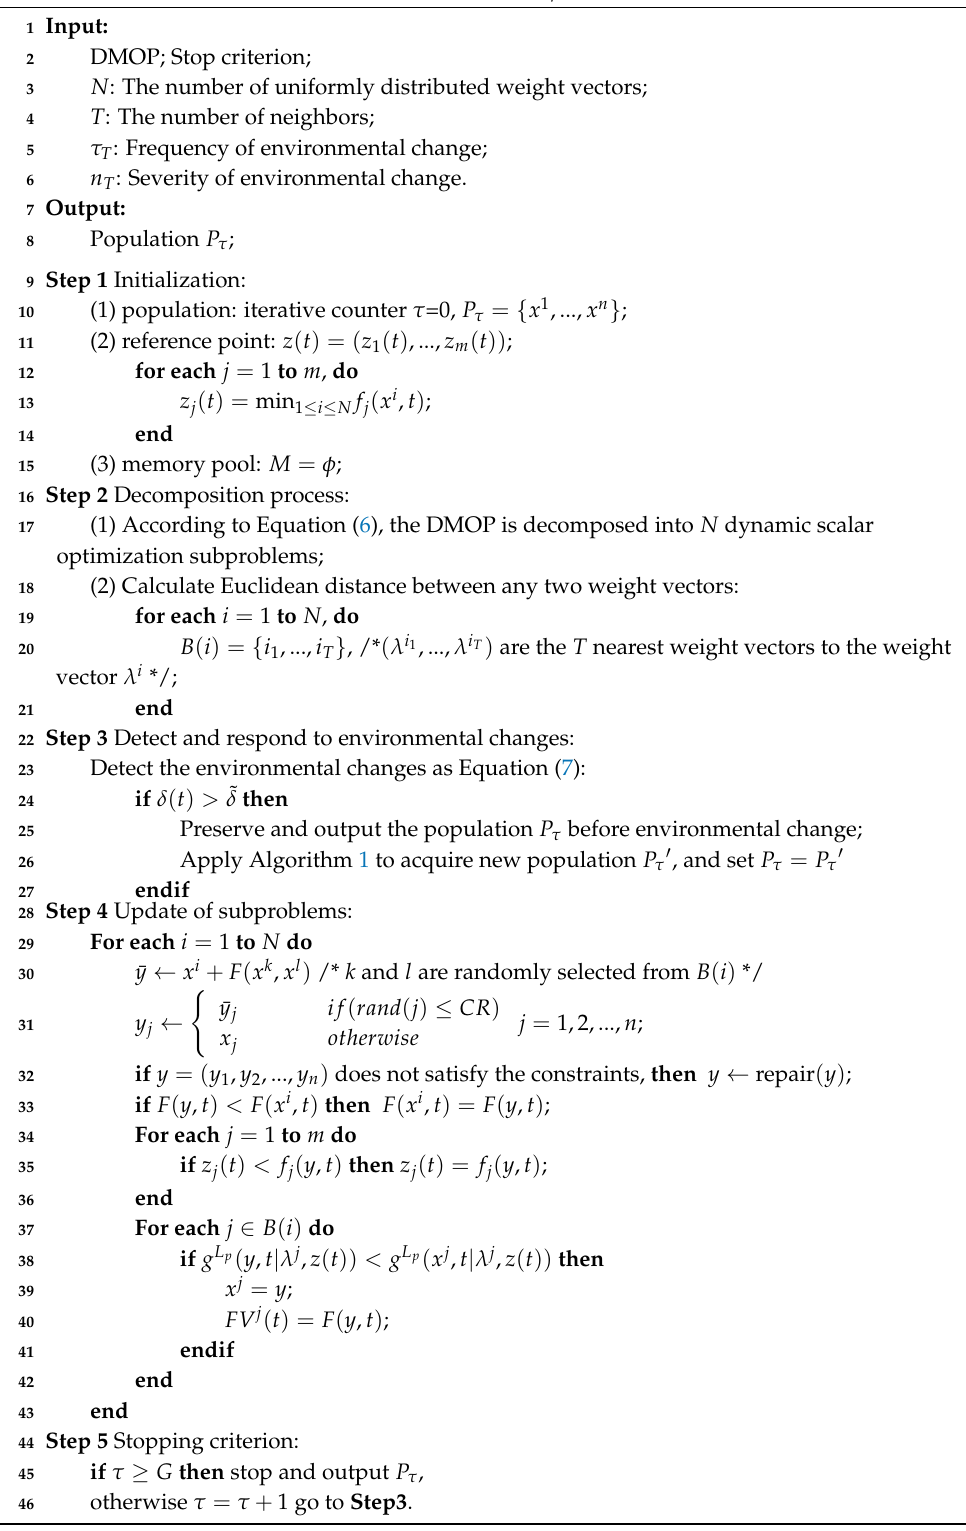
Algorithm 2: The overall framework of dMOEA/D- L